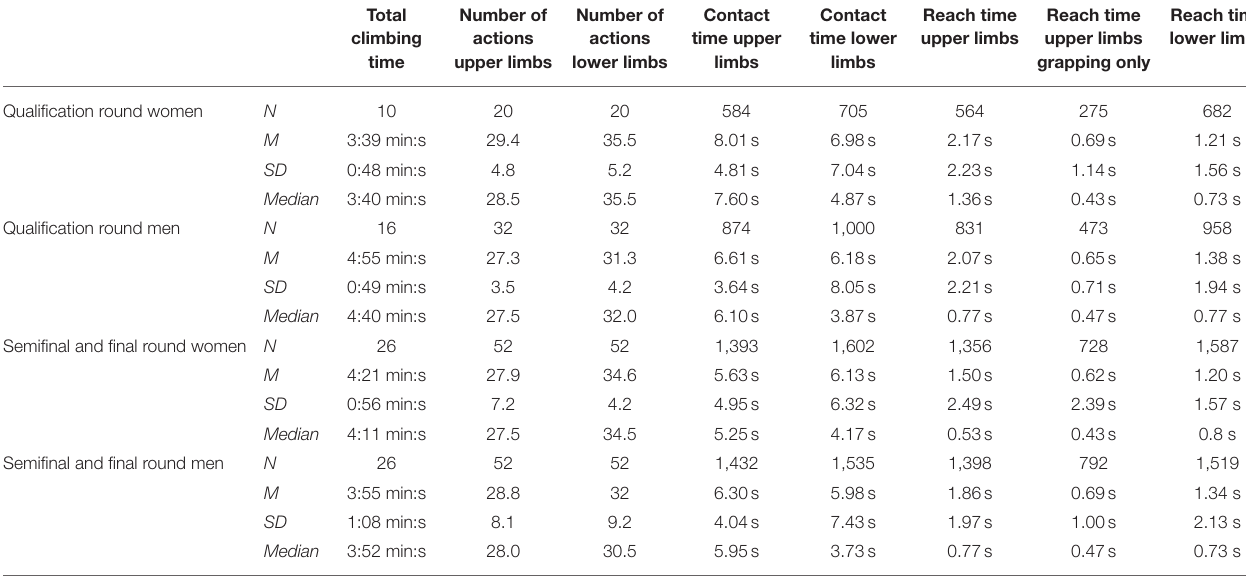
TABLE 4 | Statistics of climbing, contact and reach time, and the number of actions at international lead climbing competitions.